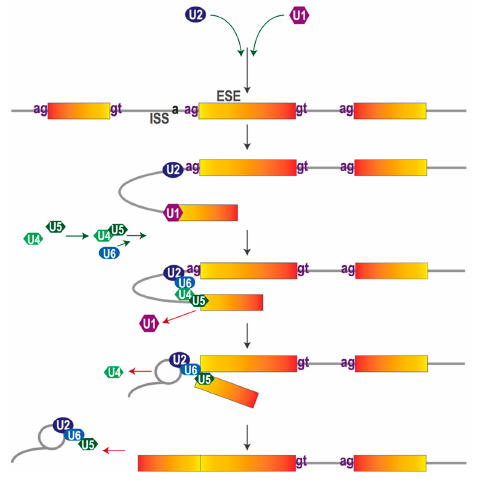
Figure 2. Small nuclear ribonucleo proteins (snRNPs) U1, U2, U4, U5 and U6 contain specific small nuclear RNA sequences of around 150 nucletorides in length which recognize and interact with cis -acting sequences guiding the splicing process [33].